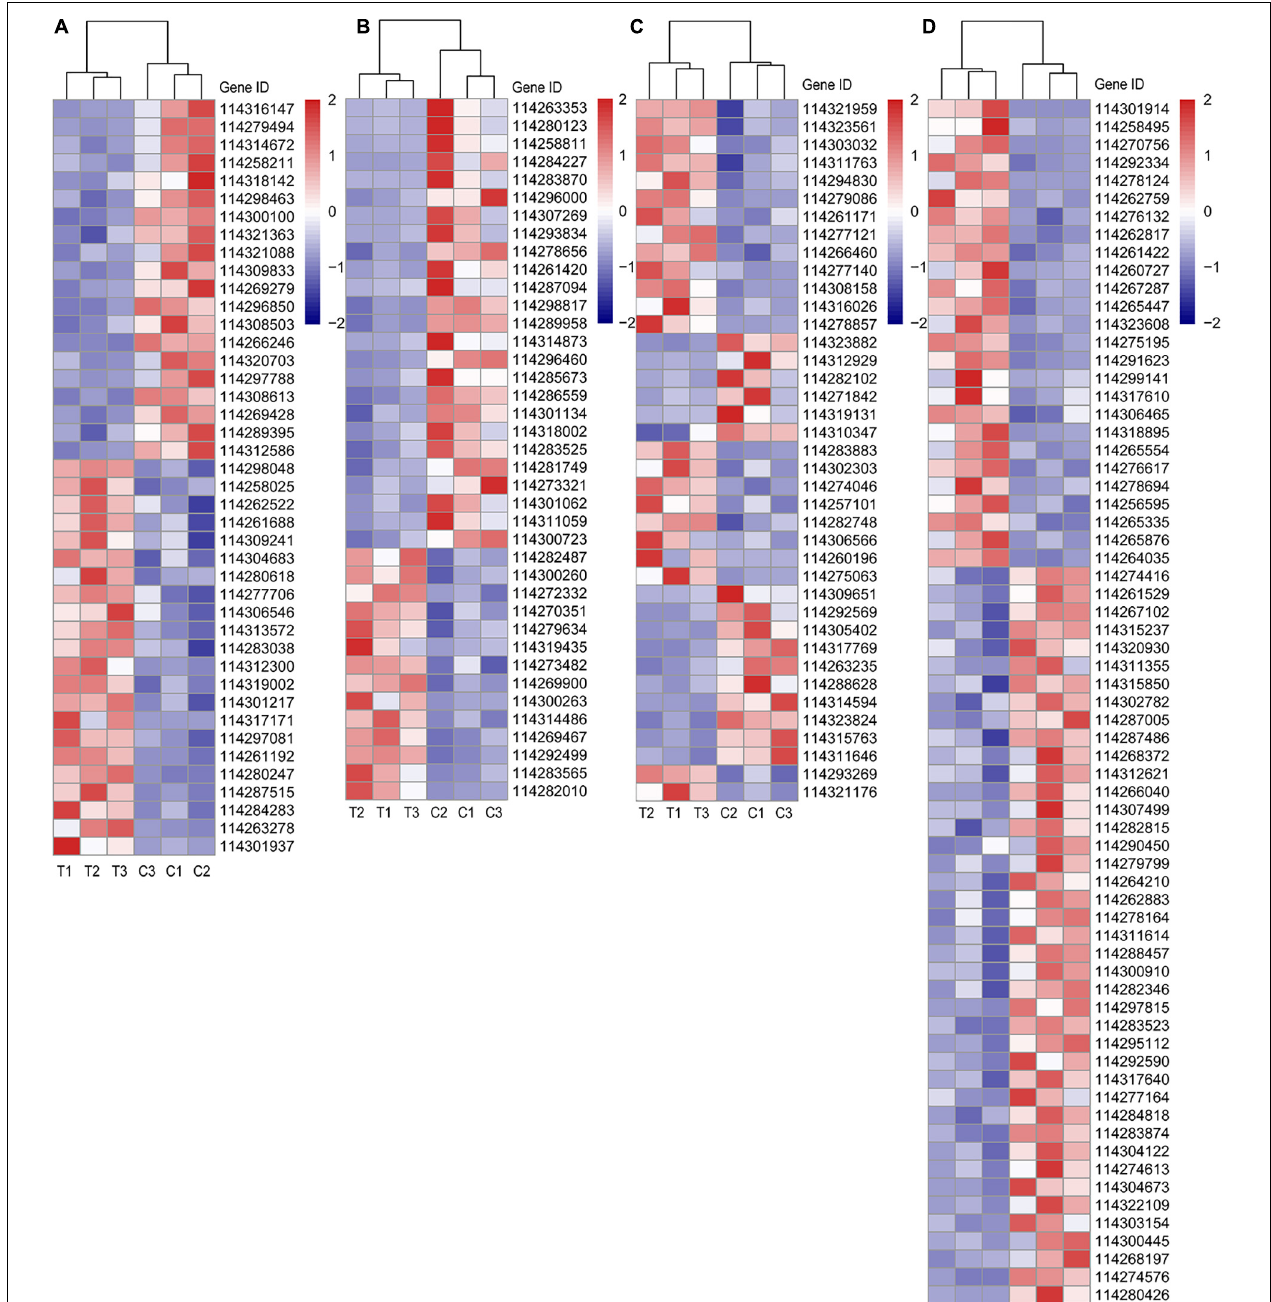
FIGURE 4 | Different categories of DEGs. (A) DEGs related to P metabolism; (B) DEGs related to sugar metabolism; (C) DEGs related to plant hormone; (D) DEGs related to lipid metabolism. C: non-mycorrhizal treatment, T: mycorrhizal treatment. The annotation of DEGs is listed in Supplementary Data 2 .